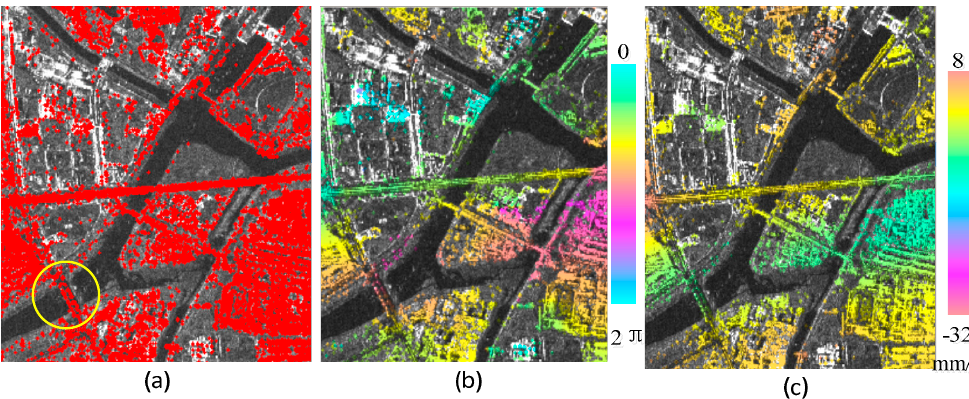
Figure 4. ( a ) Permanent Scatterer (PS) points of the selected region (yellow circle represents Wenyuhe Bridge); ( b ) the filtered differential interferogram of PS points; and ( c ) the linear deformation results of the region.